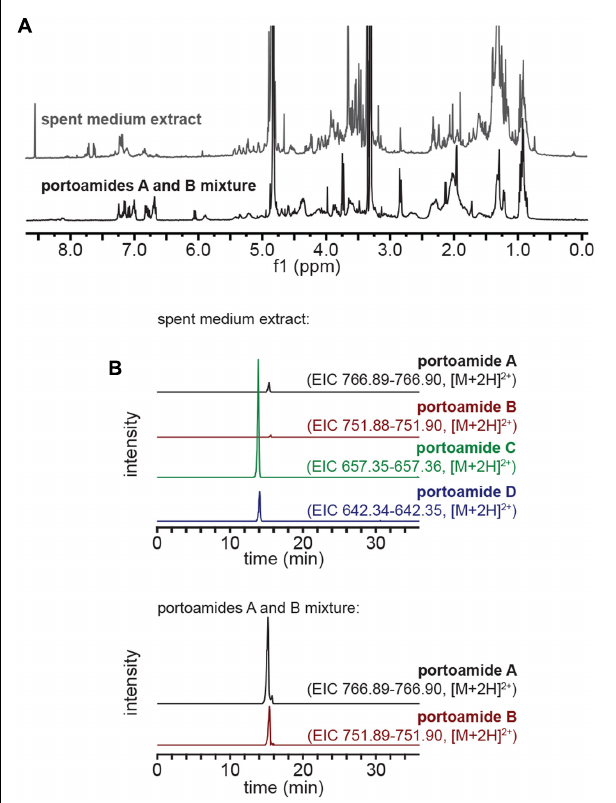
FIGURE 1 | Characterization of the spent medium extract and portoamide mixture samples. (A) 1 H NMR (CD 3 OD, 400 MHz) profiles of the spent medium extract and purified portoamides A and B mixture. (B) Extracted ion chromatograms (EICs) for portoamides obtained from LC-HRESIMS analyses of the spent medium extract (top) and portoamides A and B mixture (bottom) – the intensity scale is the same for EICs obtained from the same